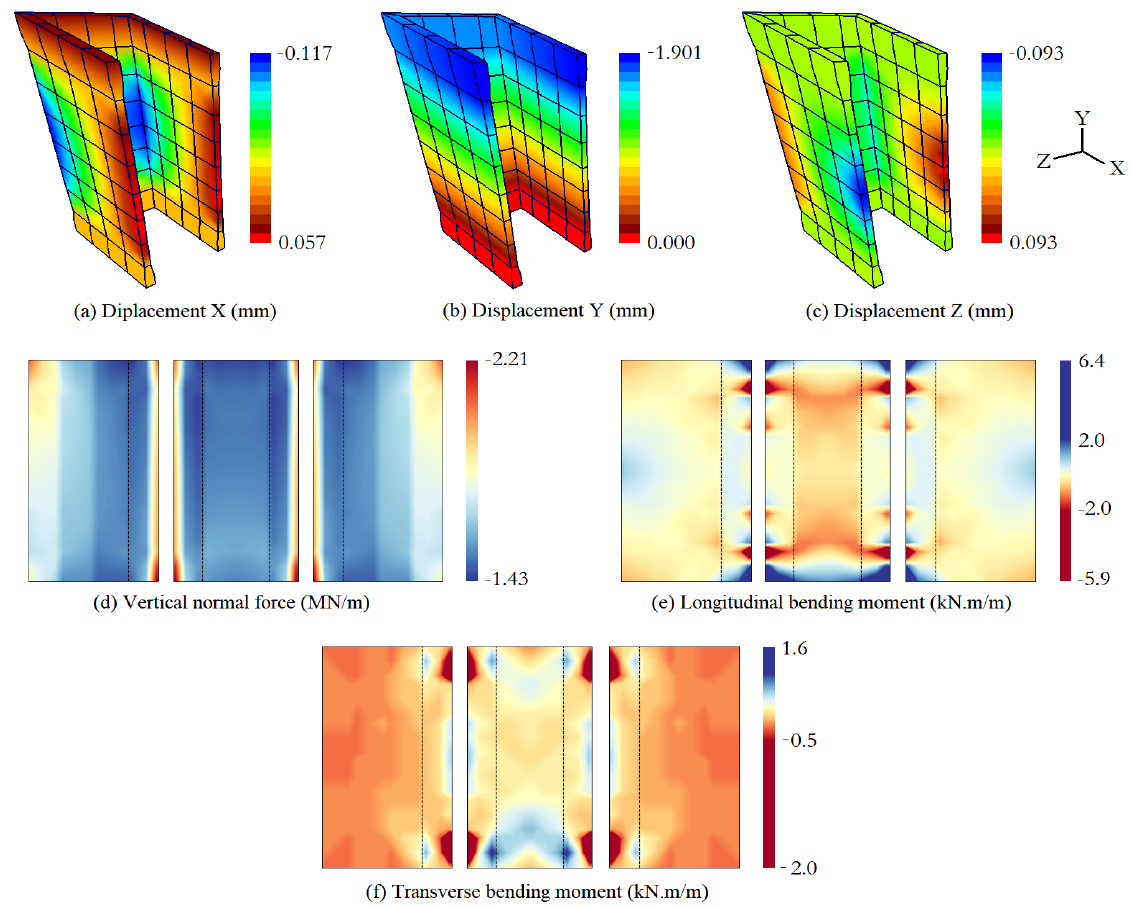
Figure 14. U- shaped shear wall results (symmetric), lateral planar wall segment λ =